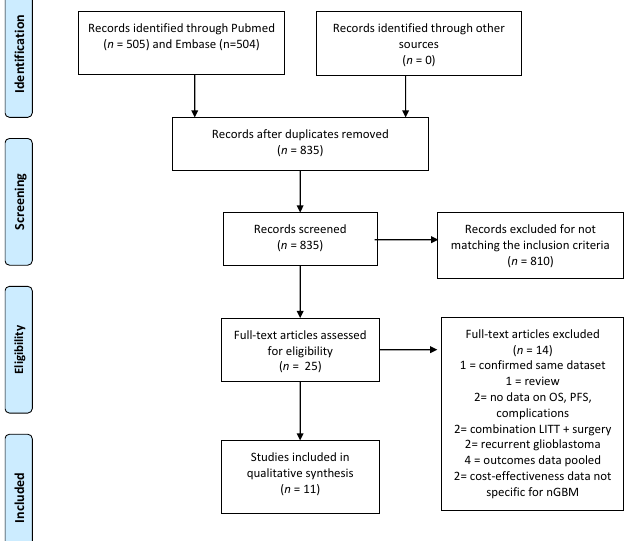
Figure 1. Preferred reporting items for systematic reviews and meta-analyses (PRISMA) flow-chart. OS: overall survival; PFS: progression free survival; LITT: laser interstitial thermal therapy; nGBM: newly diagnosed glioblastoma. Table 1. Risk of bias according to the ROBINS-I tool.